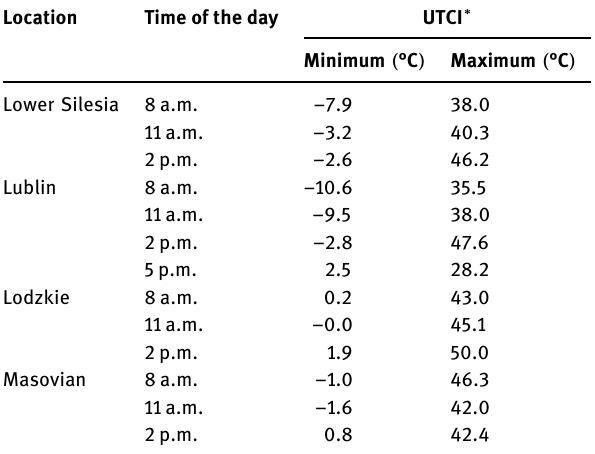
Table 2: UTCI ∗ for Lower Silesia, Lublin, Lodzkie, and Masovian voivodeships Location Time of the day UTCI ∗ Minimum ( °C ) Maximum ( °C ) Lower Silesia 8 a.m.